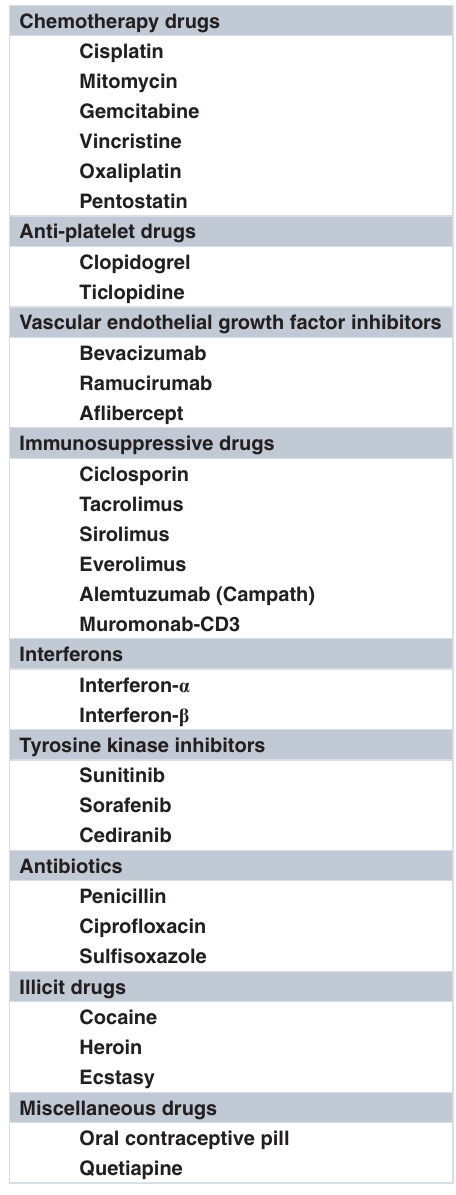
Table 2. Drugs implicated in the development of a thrombotic